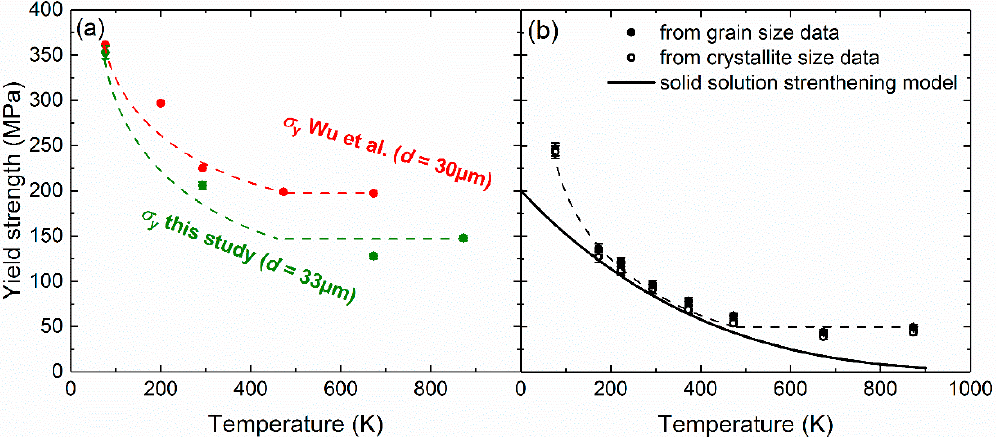
Figure 11. Temperature dependence of ( a ) yield strength obtained by Wu et al. [9] (red points) for a grain size of 30 µ m compared to values obtained in the present study for a grain size of 33 µ m (green points) and ( b ) intrinsic lattice strength of a polycrystal with an infinite grain/crystallite size. Black data points were obtained from Figure 6a by extrapolating the Hall–Petch plots to an infinite grain size while the empty symbols were determined by extrapolating the plots to an infinite crystallite size (Figure 6b). Also shown in ( b ) is the temperature dependence of the intrinsic lattice strength (black line) computed using the solid solution strengthening model of Varvenne et al. [47].